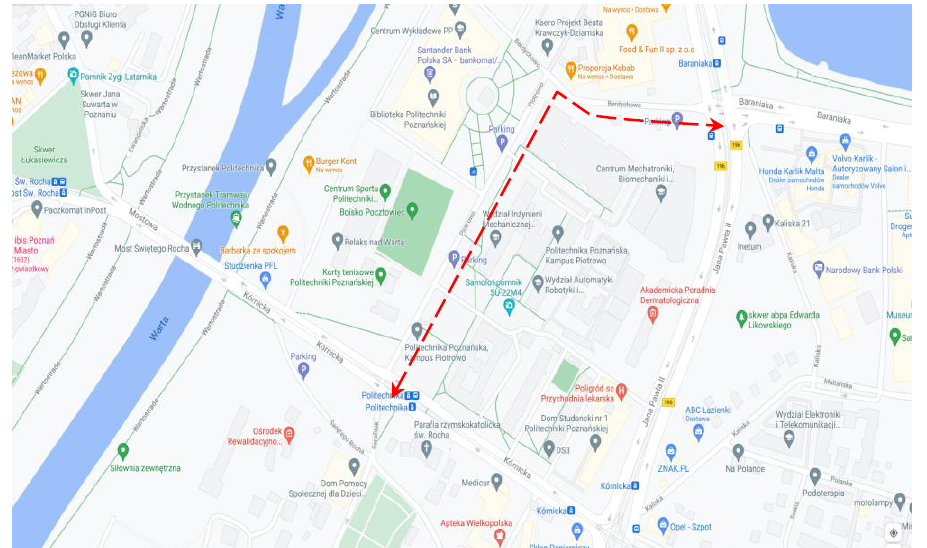
Fig. 1. Piotrowo and Berdychowo Streets in Poznań (red dotted line), the closing of which was analyzed in this